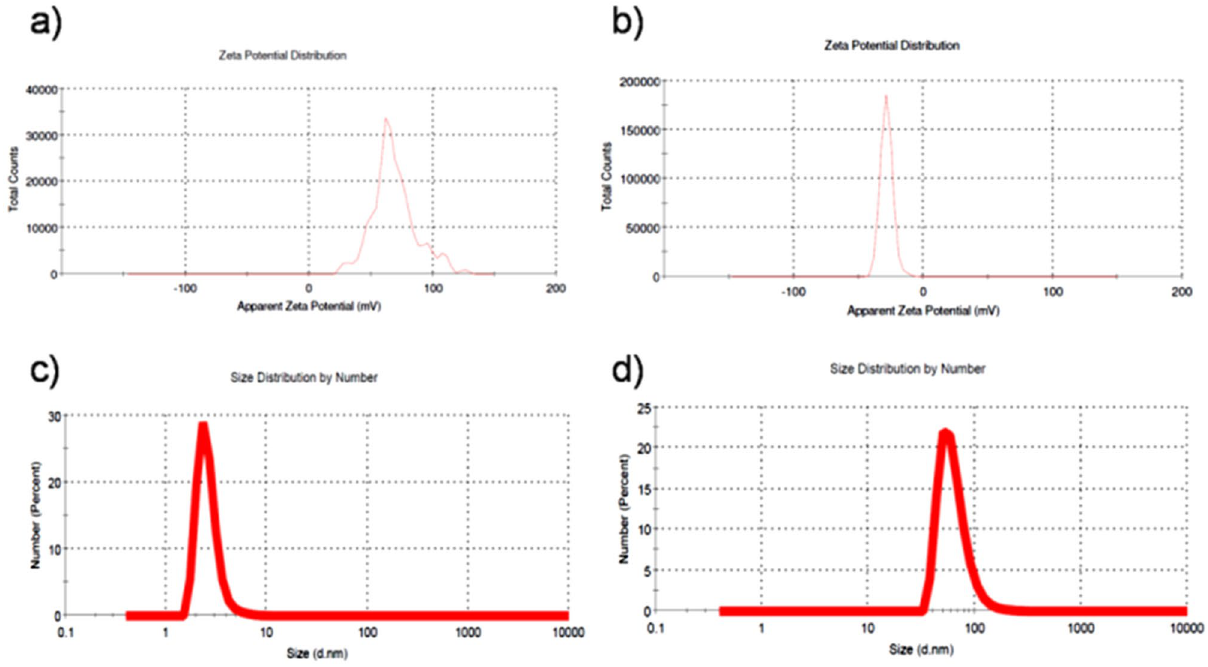
Figure. 5. Dynamic light scattering measurements. Zeta potential for ( a ) TPP-CTAC©AuNTs (23.9 ± 3.93 mV and ( b ) TPP-PSS@CTAC©AuNTs (− 28.4 ± 4.93 mV). Particle size distribution analysis for ( c ) TPP- CTAC©AuNTs (48.50 ± 2.60 nm with PDI value of 0.324) and ( d ) TPP-PSS@CTAC©AuNTs (110.7 ± 2.41 nm with PDI value of 0.277).